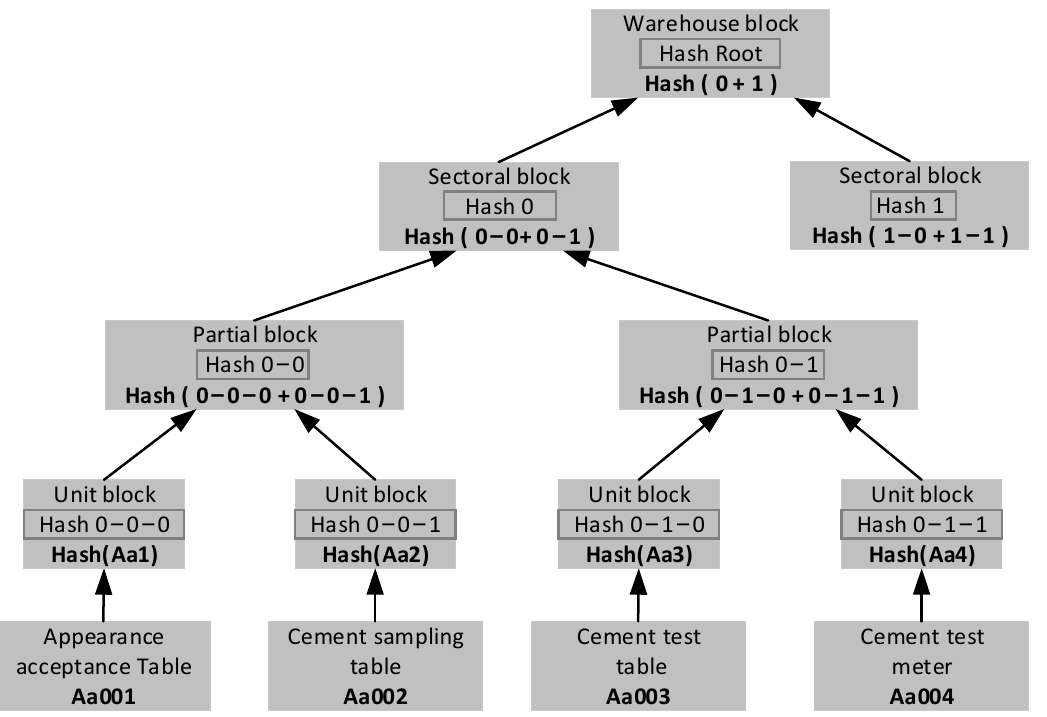
Figure 7. Merkel tree structure diagram.